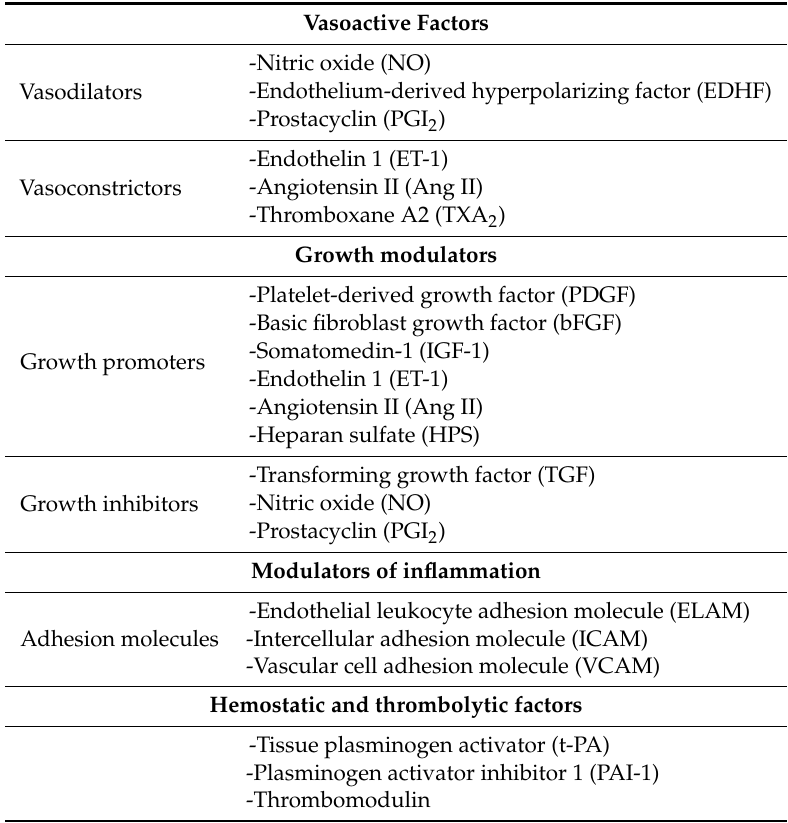
Table 1. Factors released by the vascular endothelium (Adapted from: De la Serna (2010)